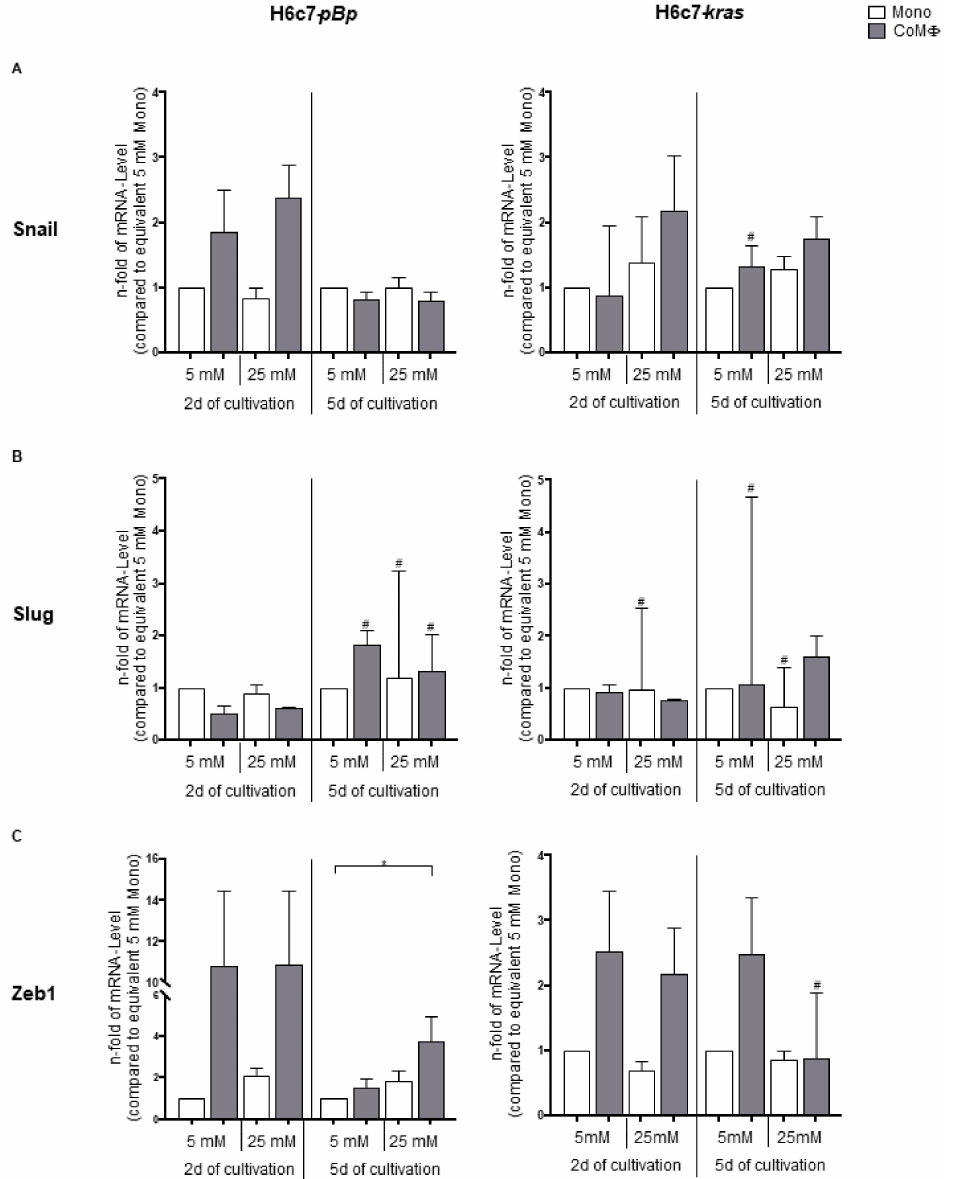
Figure 2. Exposure to M1 macrophages and hyperglycemia alters the mRNA levels of EMT- and CSC-associated transcription factors in PDEC. H6c7- pBp or H6c7- kras cells were cultivated in mono- or coculture with M1-polarized macrophages (M Φ ) under normo- or hyperglycemic conditions (5 or 25 mM of D -glucose) for 2 or 5 days. The epithelial cells were separated from direct coculture with macrophages via CD11b-MACS depletion of M1-M Φ or harvested from monoculture and used for qRT-PCR analysis. The relative mRNA levels of Snail ( A ), Slug ( B ) and Zeb1 ( C ) for both cell lines are depicted. They are normalized to the housekeeping gene GAPDH and presented as n -fold expression compared with the monocultured 5 mM sample from the equivalent cultivation timespan. Normally distributed data are presented as mean and standard error of mean; not normally distributed data (indicated via #) are shown as median and interquartile range. * 0.05 > p > 0.0332; n = 4 for 2-day culture; n = 7 for 5-day